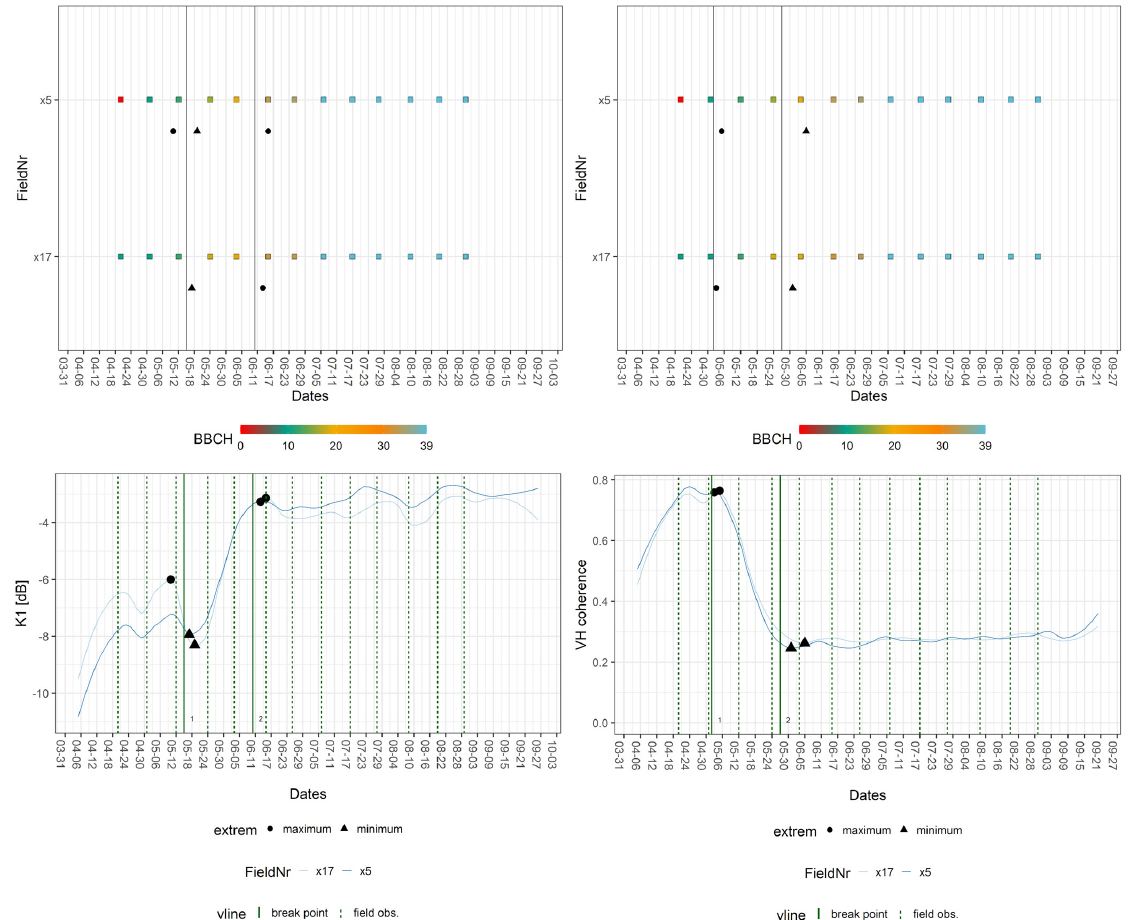
Figure 8. Exemplary breakpoint and extreme value analysis for K1 and VH coherence signatures of sugar beet fields. Upper part: BBCH progression of in situ measurements per field with dates of breakpoints (vertical line = breakpoint) and extrema (extreme). Lower part: crop signatures with breakpoints and extrema as well as dates of closest field observations (vertical line = field obs.).